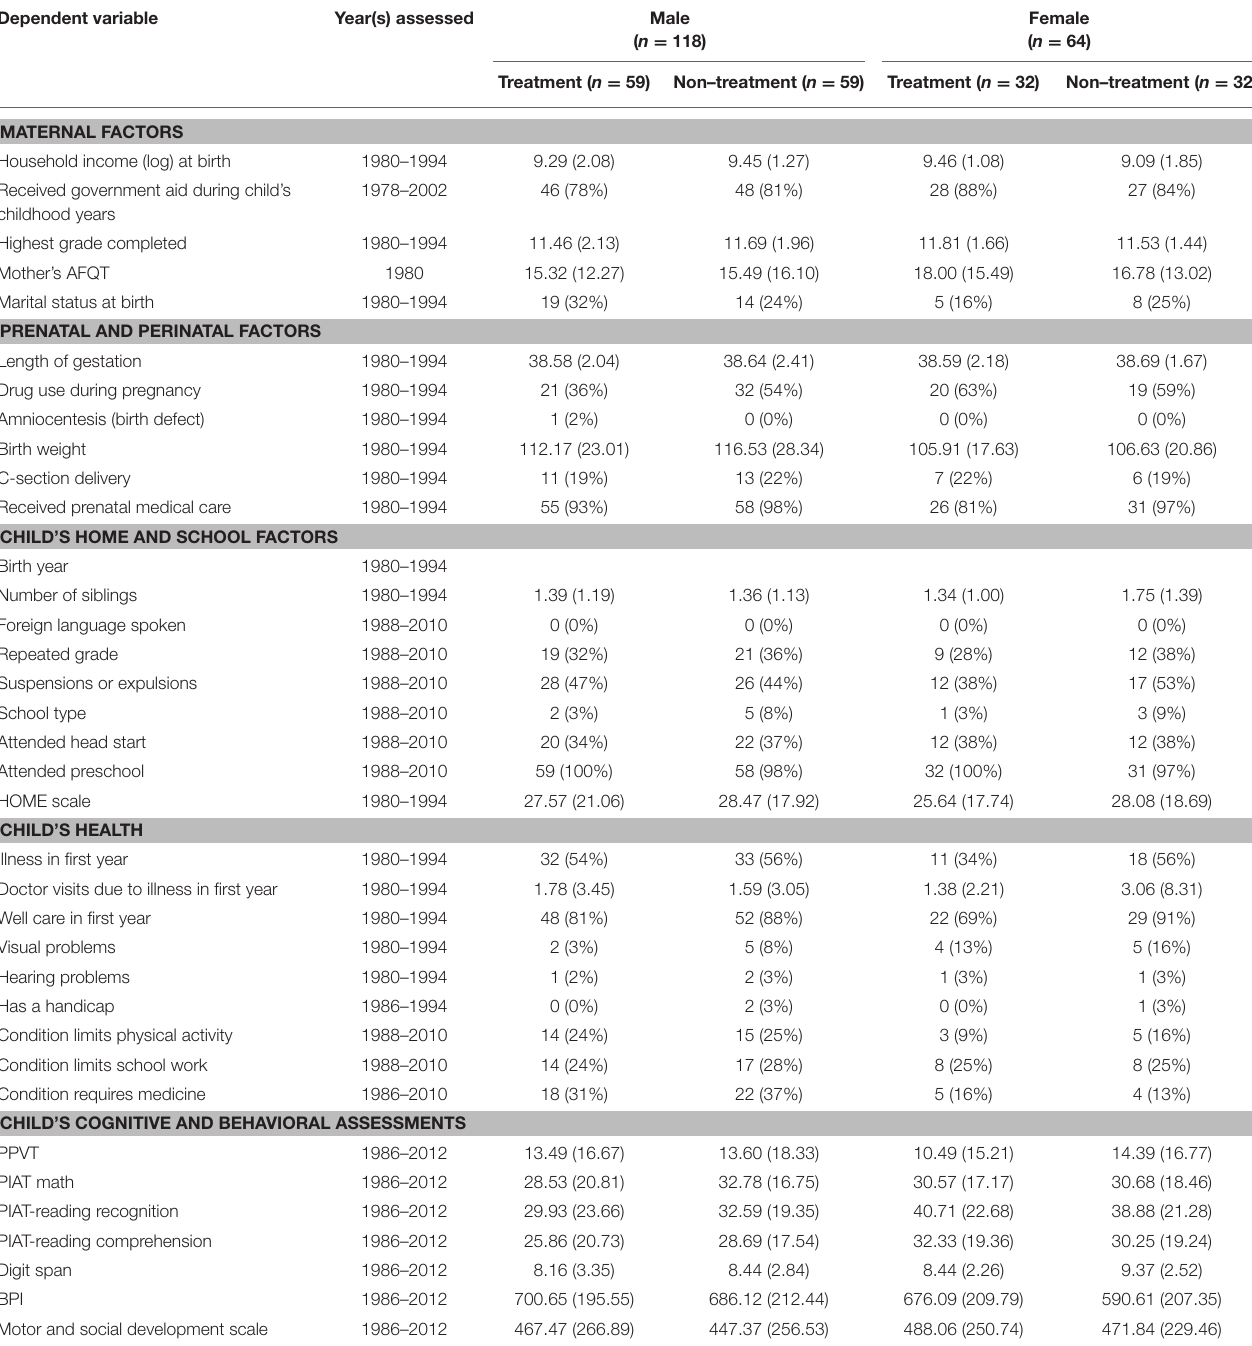
TABLE 3 | Dependent variables used in calculating propensity score and balance check for blacks ( n =